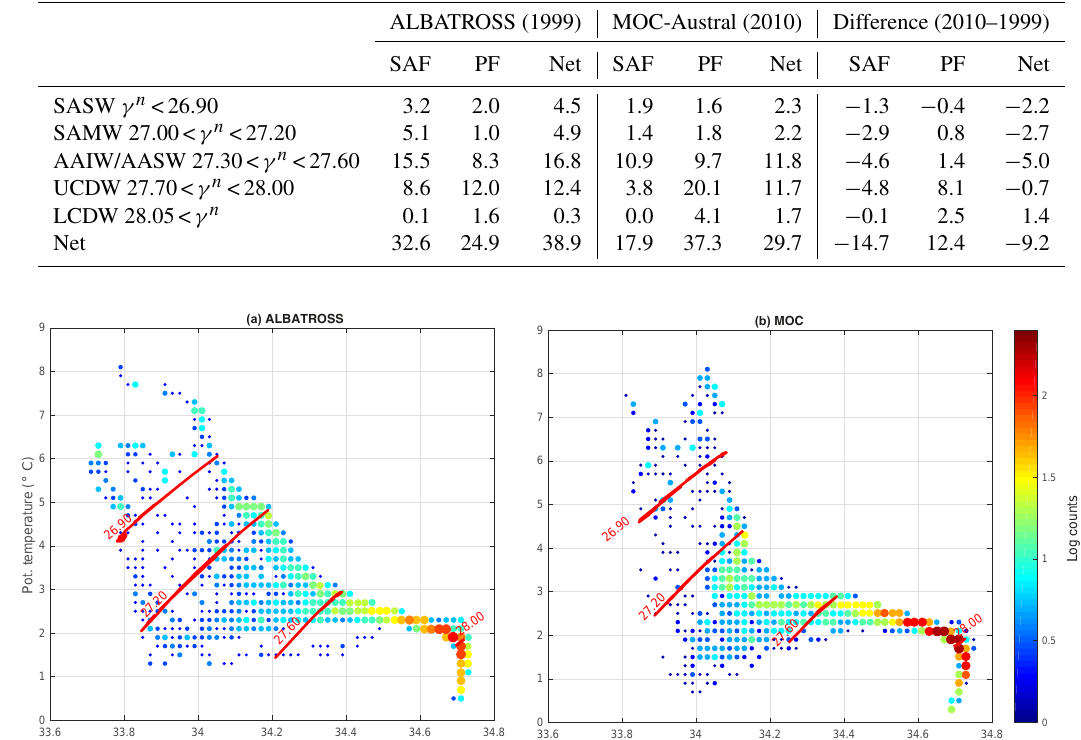
Figure 2. A volumetric potential temperature–salinity diagram for the (a) ALBATROSS and (b) MOC-Austral cruises. Red solid lines represent the γ n values (26.90, 27.20, 27.60 and 28.00kgm − 3 ) defining the different water masses in the region. Dot size and color indicate the logarithm of